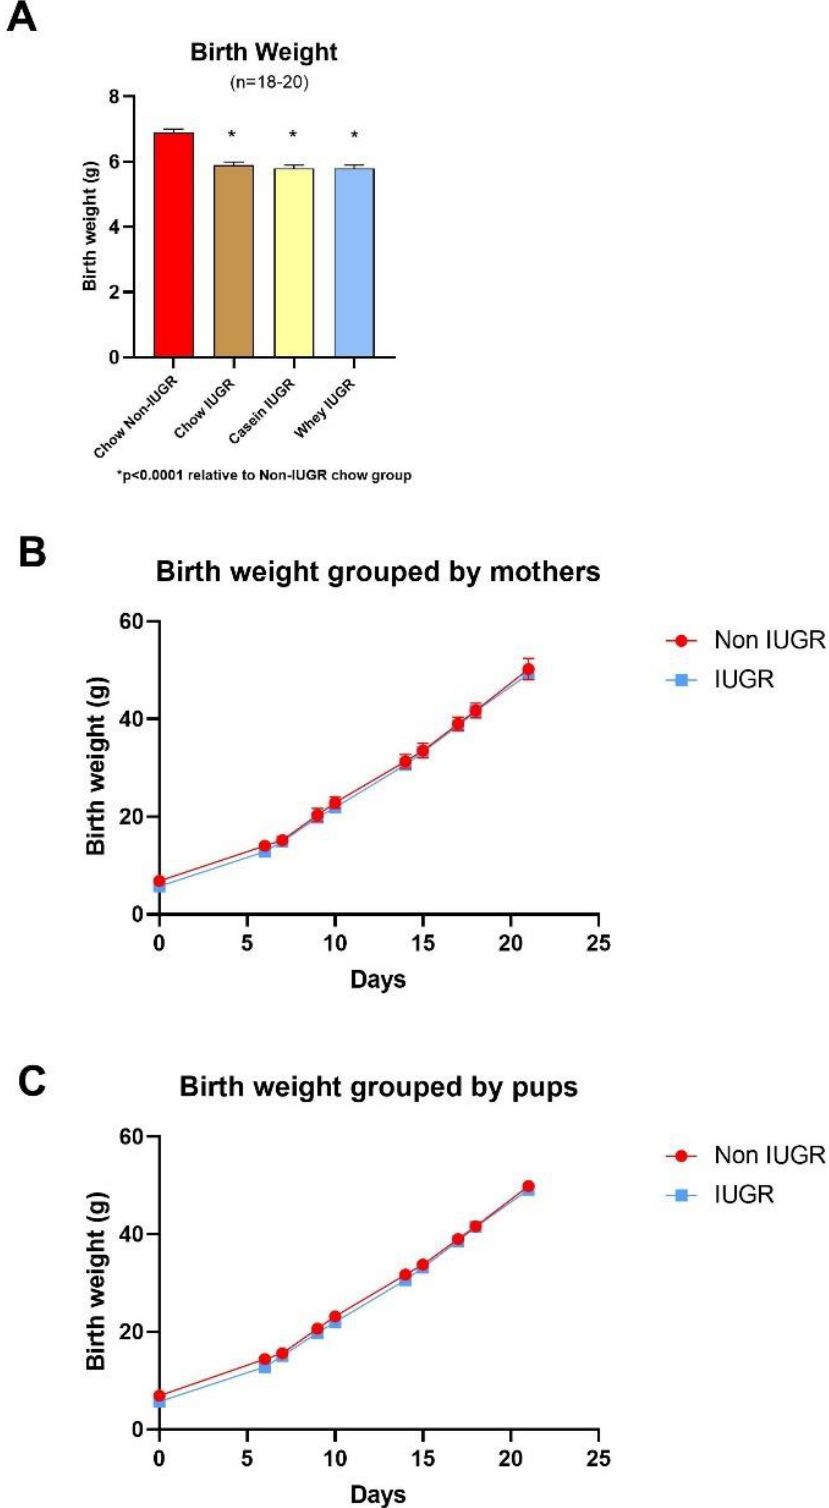
Figure 2. Birth weight. ( A ) Birth weight in grams; ( n = 18–20); ( B ) birth weight grouped by litter (IUGR n = 14; non-IUGR n = 6) and ( C ) birth weight grouped by pups (IUGR n = 58; non-IUGR n = 19). All IUGR groups were significantly lower than non-IUGR. Values are mean ± SEM.